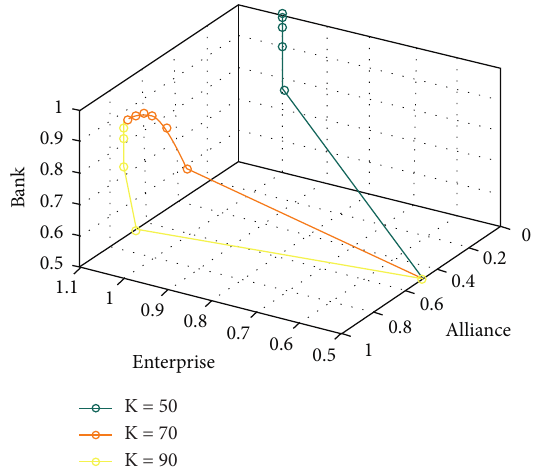
Figure 3: Three-party evolutionary game trajectory under different information service fees.